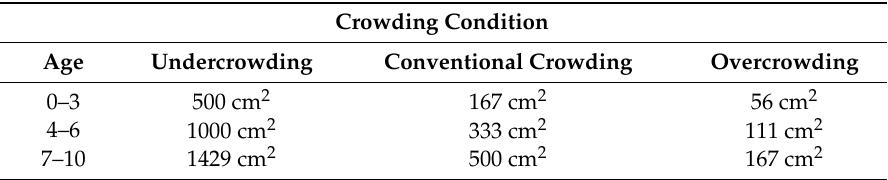
Table 2. Crowding conditions per group in available cm 2 per chick. Age is depicted in weeks, and cages were enlarged at two time-points. Stocking densities were based on industry-numbers (taken as guiding value for conventional crowding) and a factor of three smaller or bigger to design the over- and undercrowding situation